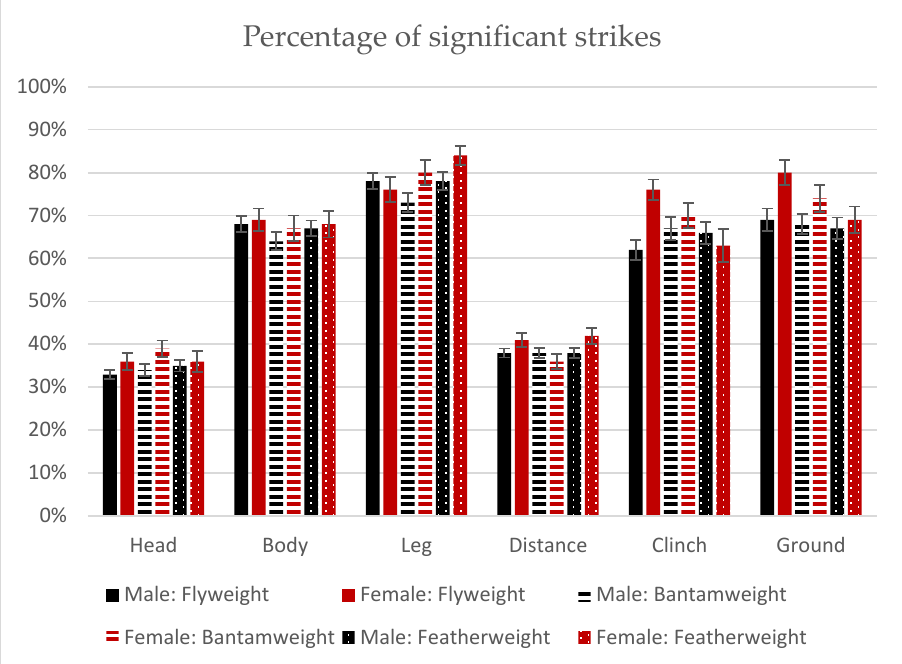
Figure 4. Percentage of significant strikes in men’s (black) and women’s (red) fights in flyweight (filled), bantamweight (striped) and featherweight (dotted) categories.